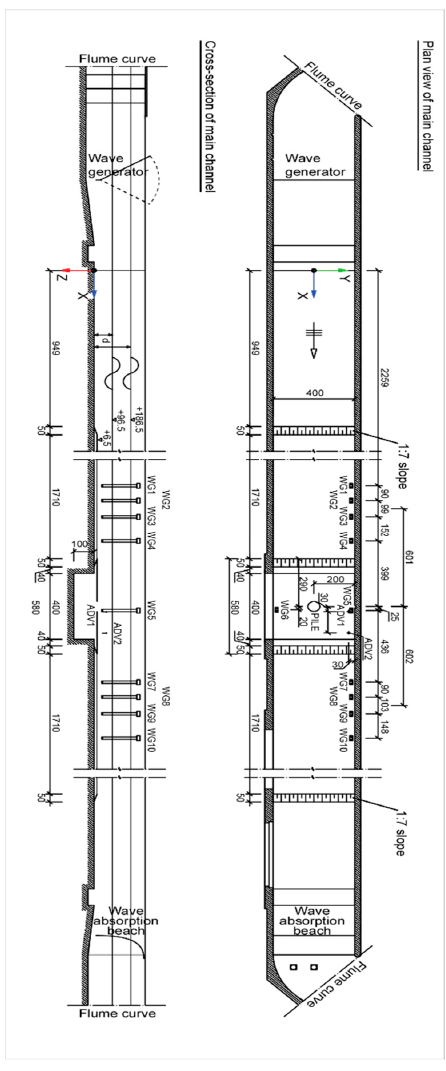
Figure 2. Overview of the FFF main channel, and of the experimental setup including the intrumentation positions, the reference coordinate system and the scale model location.